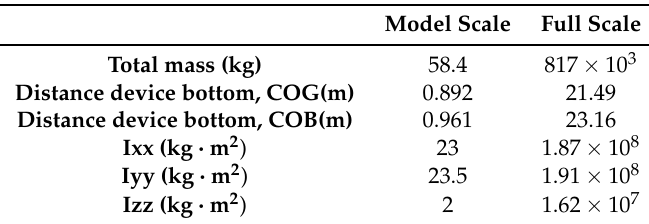
Table 1. Devices mass properties.